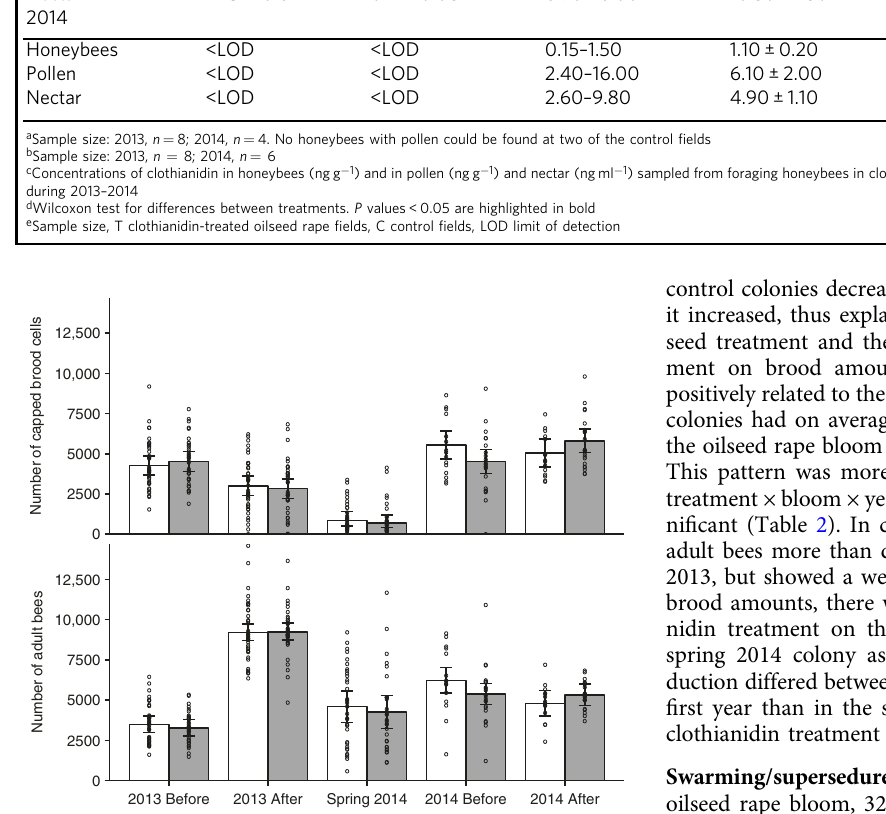
Fig. 2 Honeybee colony development. The mean (±95% con fi dence limits) number of adult bees and the number of capped brood cells per colony in relation to seed treatment (control = white bars; clothianidin-treated = grey bars) in oilseed rape fi elds before and after the oilseed rape bloom in two years (2013 and 2014) and at the 2014 spring inspection; n = 8 fi elds per treatment in 2013 and n = 4 control fi elds and 6 clothianidin-treated fi elds in 2014. Circles indicate measured values per colony